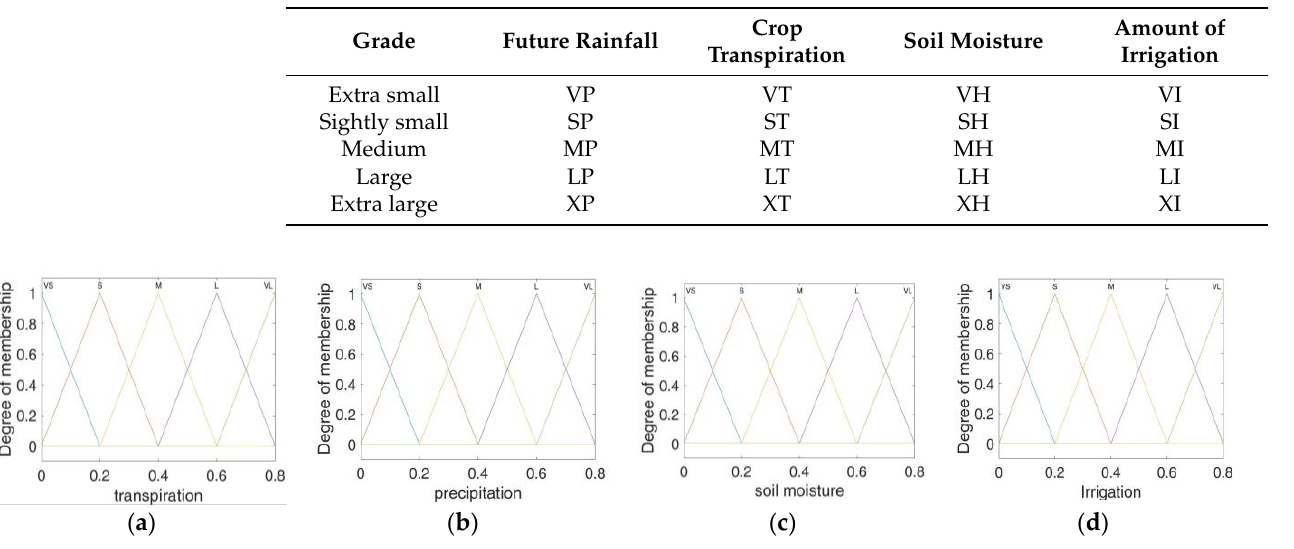
Figure 11. Affiliation functions for input and output quantities: ( a ) transpiration affiliation function; ( b ) precipitation affiliation function; ( c ) soil moisture affiliation function; and ( d ) irrigation volume affiliation function.